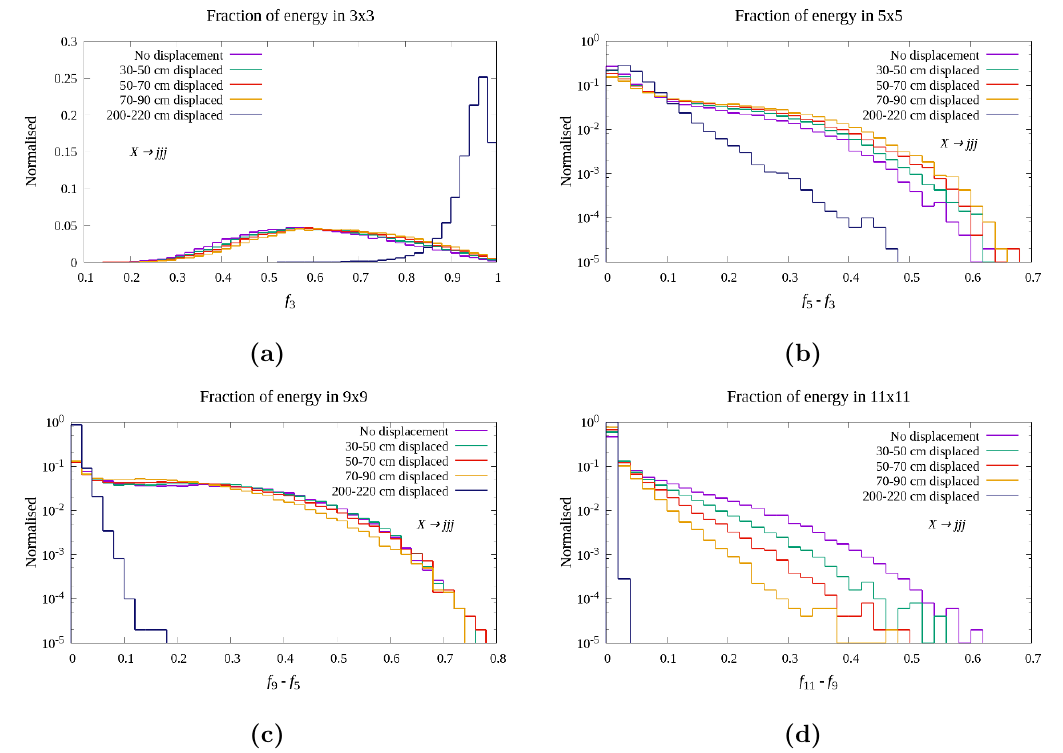
Figure 6. Normalised distributions of energy deposition fraction ( f i ) with varying sizes of blocks ( i (cid:2) i ). (a) Fraction of energy deposited in 3 (cid:2) 3; (b), (c), (d) Fraction of energy deposited in 5 (cid:2) 5, 9 (cid:2) 9 and 11 (cid:2) 11 excluding the previous 3 (cid:2) 3, 5 (cid:2) 5 and 9 (cid:2) 9 blocks’ energy deposition fraction